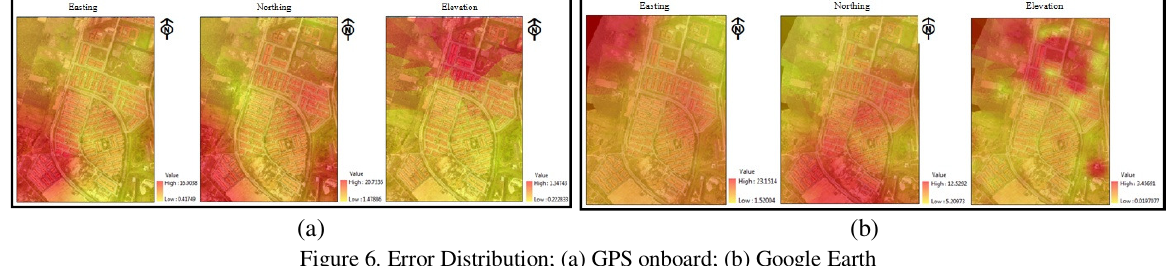
Figure 6. Error Distribution; (a) GPS onboard; (b) Google Earth